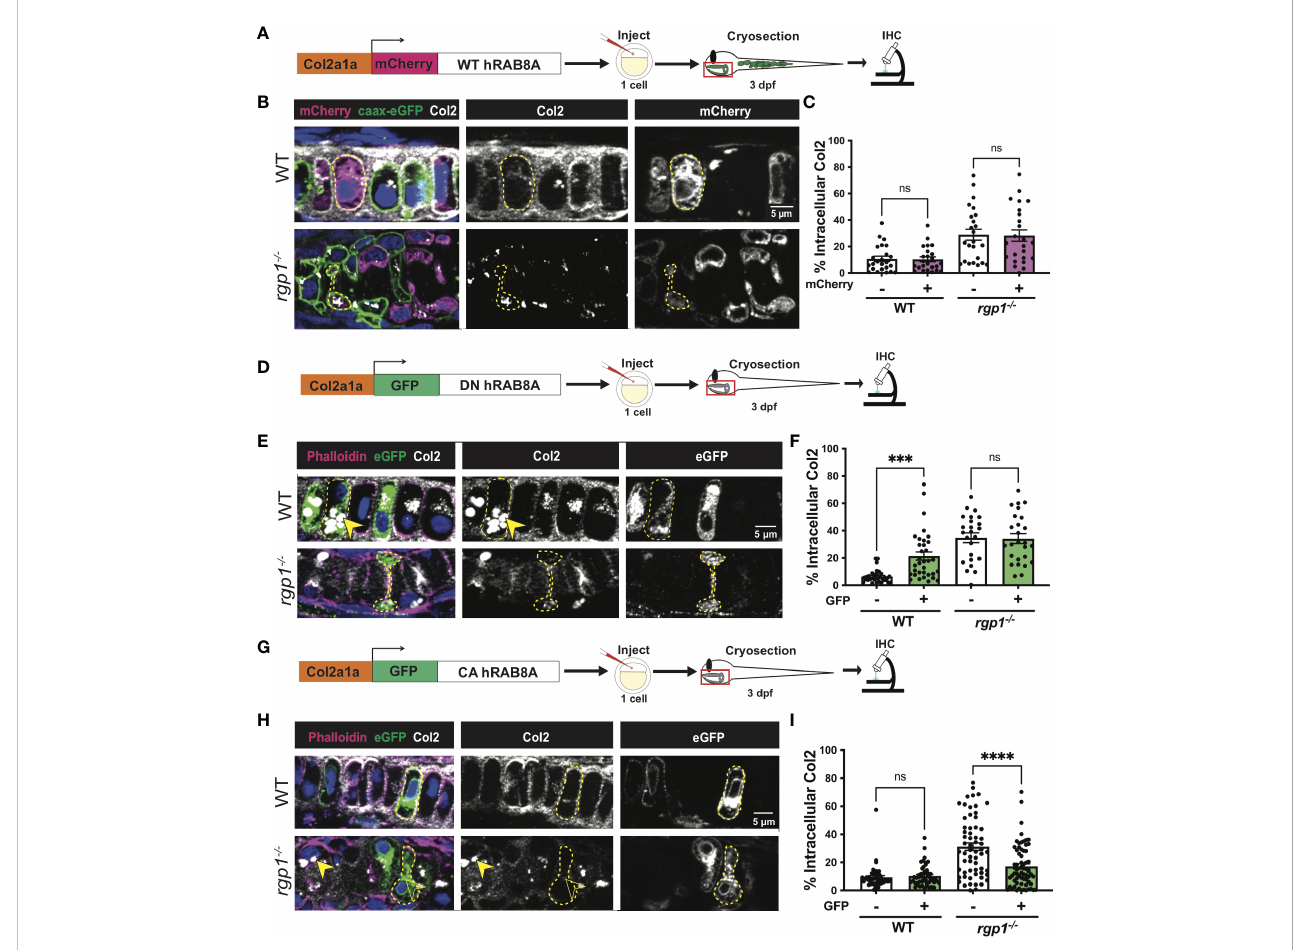
FIGURE 5 Collagen II traf fi cking is regulated by Rab8a. (A) Experimental design for mosaic overexpression of WT mCherry-hRAB8A fusion protein in zebra fi sh chondrocytes. (B) Representative images of Tg(Col2a1 a :caax-eGFP) transgenic chondrocytes in WT and rgp1 -/- cartilage (mCherry, magenta; caax-eGFP, green; Col2, white). (C) Quanti fi cation of the percentage of cytosolic area occupied by collagen II signal in chondrocytes. (D) Experimental design for mosaic overexpression of DN GFP-hRAB8A fusion protein in zebra fi sh chondrocytes. (E) Representative images of chondrocytes in WT and rgp1 -/- cartilage (phalloidin, magenta; eGFP, green; Col2, white). Yellow arrowhead identi fi es intracellular collagen II. (F) Quanti fi cation of the percentage of cytosolic area occupied by collagen II signal in chondrocytes. (G) Experimental design for mosaic overexpression of CA GFP-hRAB8A fusion protein in zebra fi sh chondrocytes. (H) Representative images of chondrocytes in WT and rgp1 -/- cartilage (phalloidin, magenta; eGFP, green; Col2, white). Yellow arrowhead identi fi es collagen II in GFP - cells while empty arrowhead identi fi es collagen II in GFP + cells. (I) Quanti fi cation of the percentage of cytosolic area occupied by collagen II signal in chondrocytes. Signi fi cance is presented by ***p<0.001; ****p<0.0001; ns, not sign fi